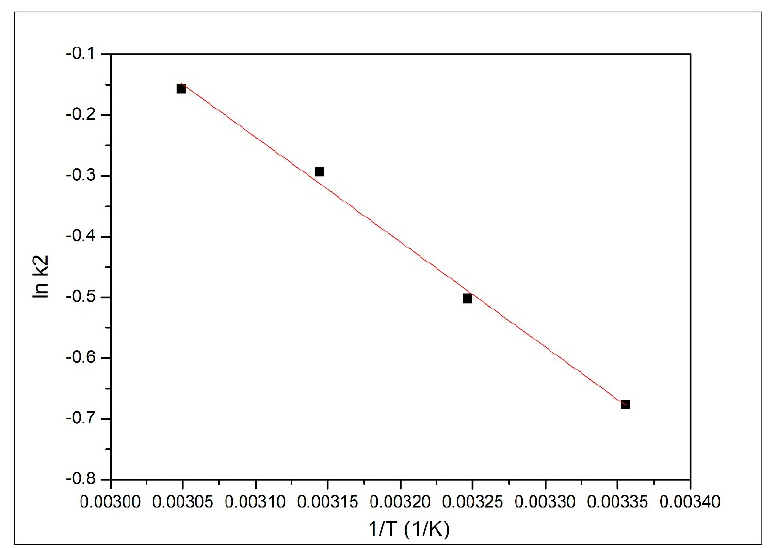
Figure 8. Arrhenius plot.